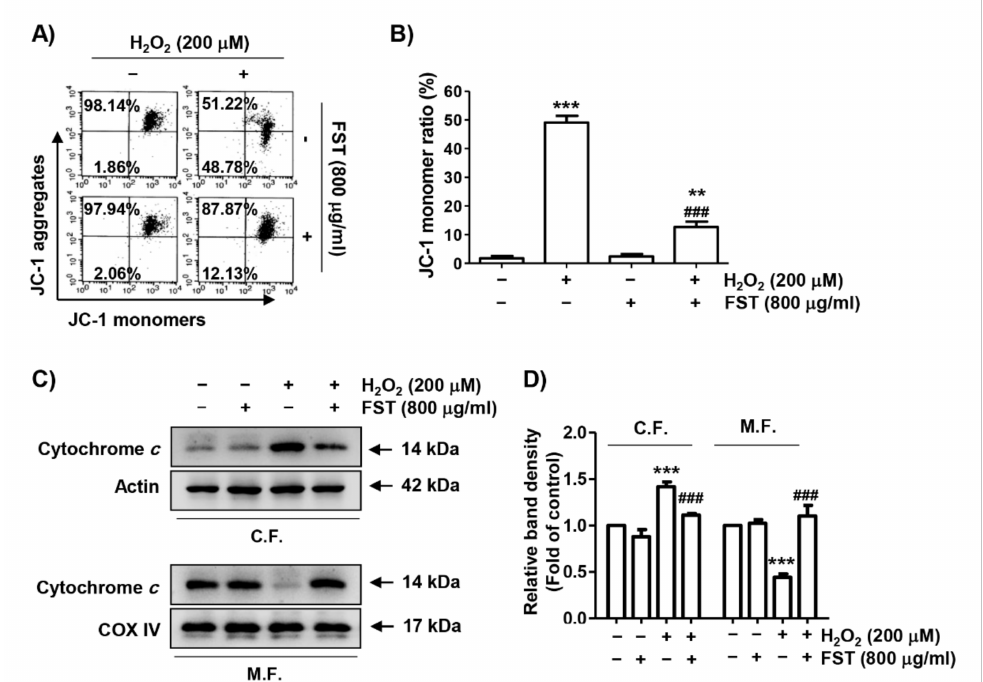
Figure 3. Effect of FST on mitochondrial damages in H 2 O 2 -stimulated MC3T3-E1 cells. Cells were pre- treated with or without FST (800 µ g/mL) and exposed to H 2 O 2 (200 µ M) for 24 h. ( A , B ) Mitochondrial membrane potential (MMP) was measured by flow cytometry after 5,5 (cid:48) 6,6 (cid:48) -tetrachloro-1,1 (cid:48) ,3,3 (cid:48) - tetraethyl-imidacarbocyanine iodide (JC-1) staining. ( A ) Representative profiles are shown. ( B ) Ratios of JC-1 aggregates to monomers are expressed. ** p < 0.01 and *** p < 0.001 vs. control cells. ### p < 0.001 vs. H 2 O 2 -treated cells. ( C ) The expression of cytochrome c in mitochondrial (M.F.) and cytoplasmic fractions (C.F.). Cytochrome c oxidase subunit IV (COX IV) and actin were analyzed as internal controls for mitochondrial and cytosolic fractions, respectively. ( D ) Relative band